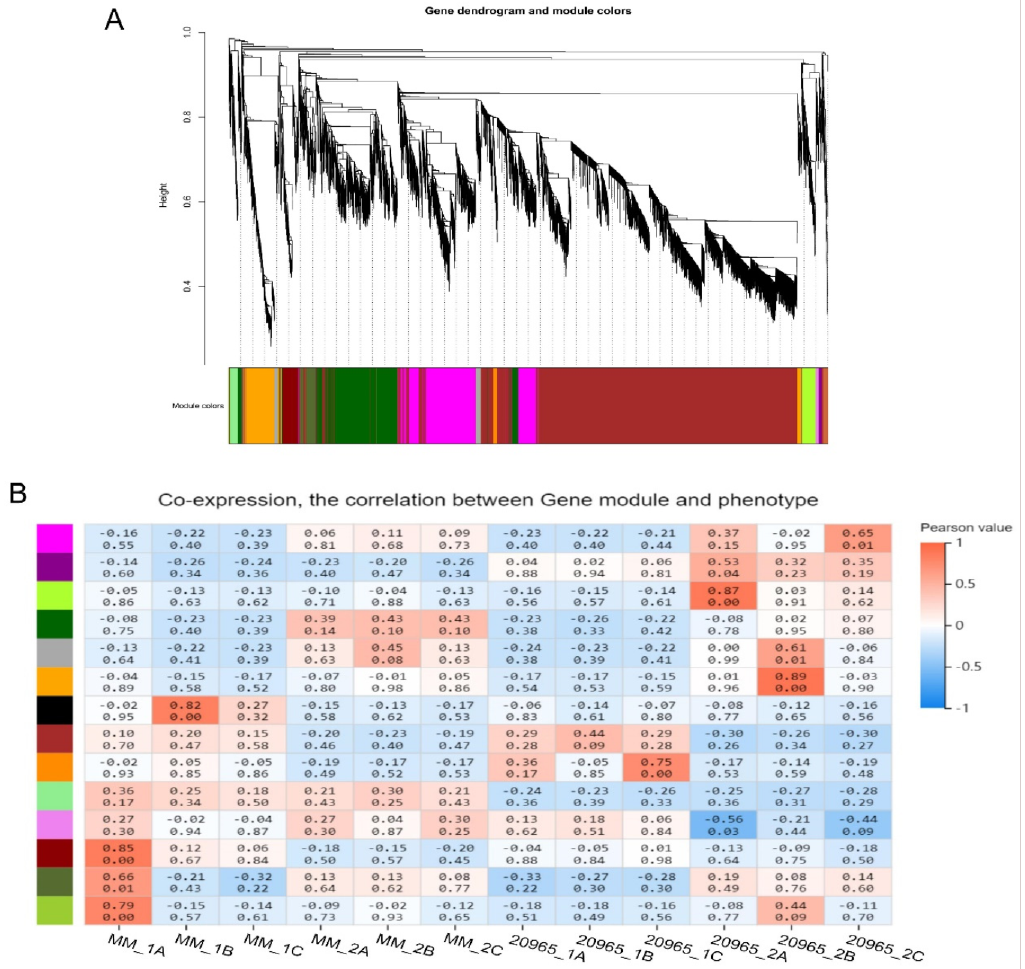
Figure 6. Analysis of expression patterns in tomato flower samples by WGCNA. ( A ) Gene clustering tree and module division. ( B ) Module-sample association. The abscissa represents the samples; the ordinate represents the modules. The upper value in each cell represents the correlation coefficient, and the lower value represents the p